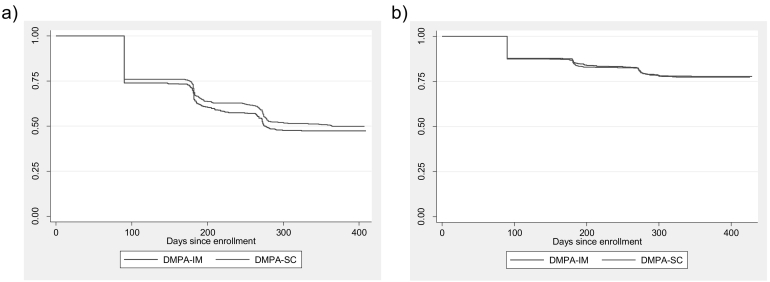
Kaplan–Meier cumulative probability of DMPA-SC and DMPA-IM continuation in (A) Burkina Faso and (B) Uganda. Log-rank test for equality of survivor function, p value=.31 (Burkina Faso) and .88 (Uganda).